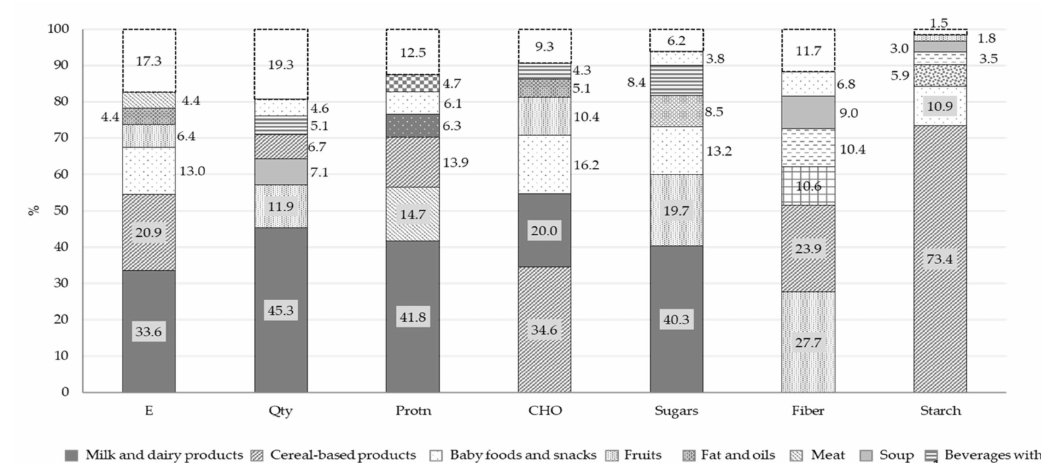
Figure 3. Percentage contribution of selected food groups to total intake of energy, food (Qty), proteins, available carbohy- drates, sugars, fiber and starch ( n = 389). * For each variable, the category “Others” includes all the food groups not consid- ered independently. Abbreviations: E, energy; Qty, quantity of food; Protn, total protein; CHO, available carbohydrates.